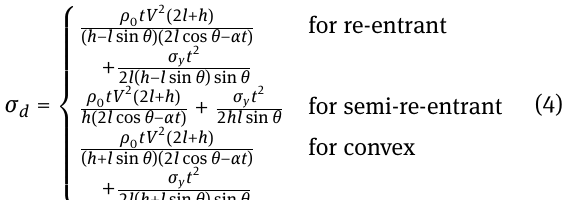
Figure 1. Based on the local continuously collapse bands assumption, the collapse mode of honeycomb is periodic and the repeatable array element is therefore selected as the RDE. In our previous work, two cells are selected at the layer (orange region) between the fully collapsed band and that in front of it as highlighted in Figure 1. Considering the momentum balance of RDE in a short time interval from T = t 0 to T = t 1 , the dynamic impact strength σ d can be written as